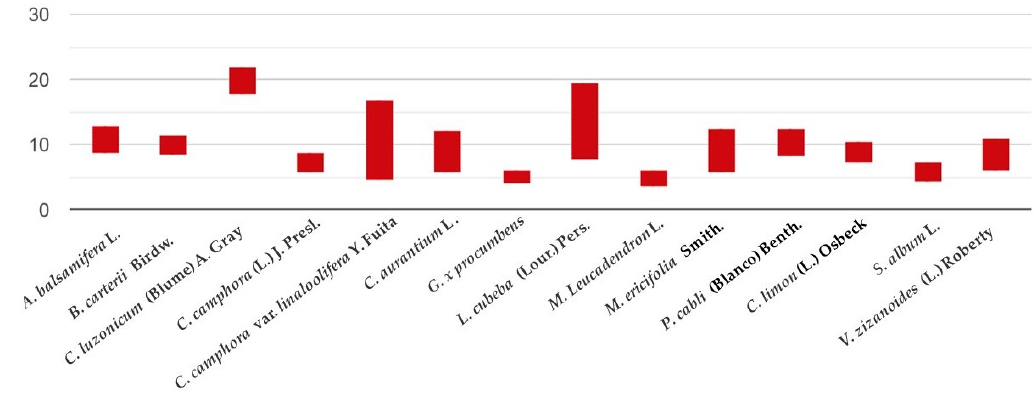
Figure 2. Mean (mm) and standard deviation for analysed essential oils in their activity against Staphylococcus spp.